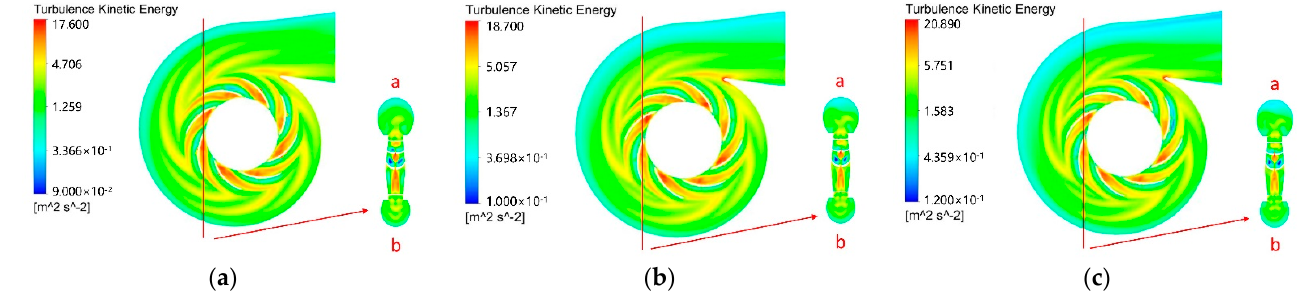
Figure 7. Cloud diagram of the variation of turbulence kinetic energy in centrifugal pump with different sediment concentrations: ( a ) clear water; ( b ) sediment concentration ρ sc = 0.1%; ( c ) sediment concentration ρ sc = 1%.